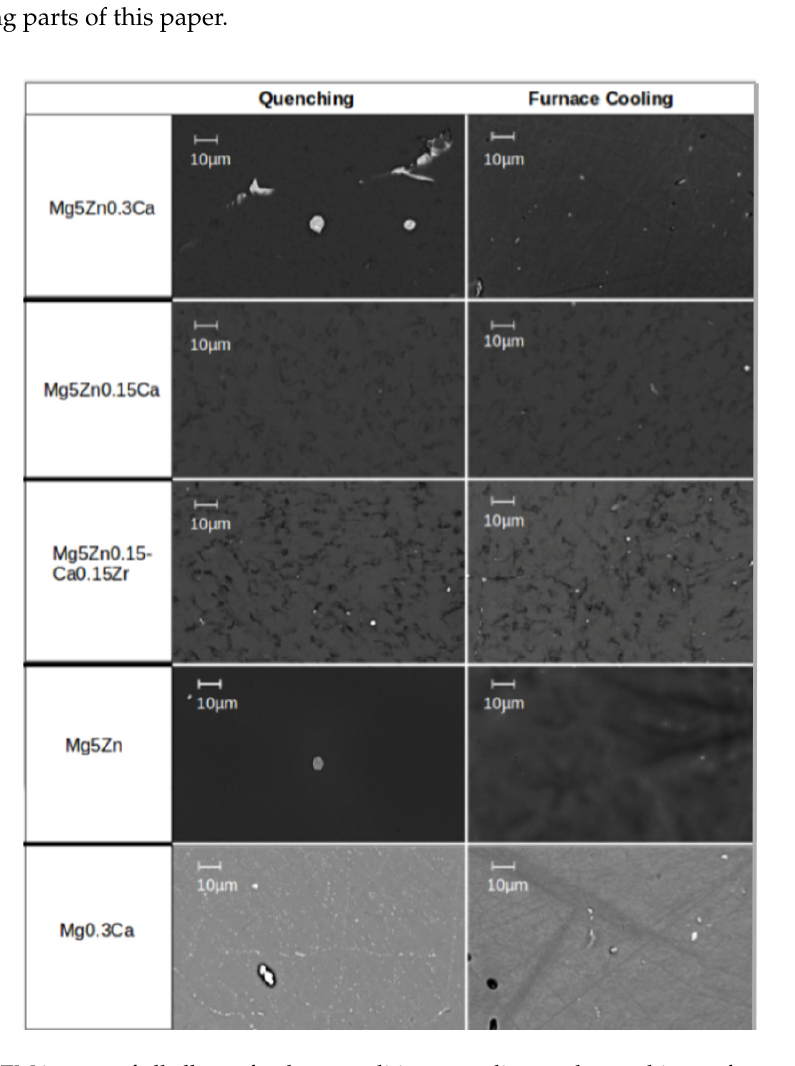
Figure 6. SEM images of all alloys after best ‐ condition annealing, and quenching or furnace ‐ cooling. The results of microhardness (HV0.05) measurements of as ‐ cast Mg5Zn0.3Ca, Mg5Zn, Mg0.3Ca, Mg5Zn0.15Ca and Mg5Zn0.15Ca0.15Zr samples, and in their furnace ‐ cooled or quenched states, are listed in Table 3.